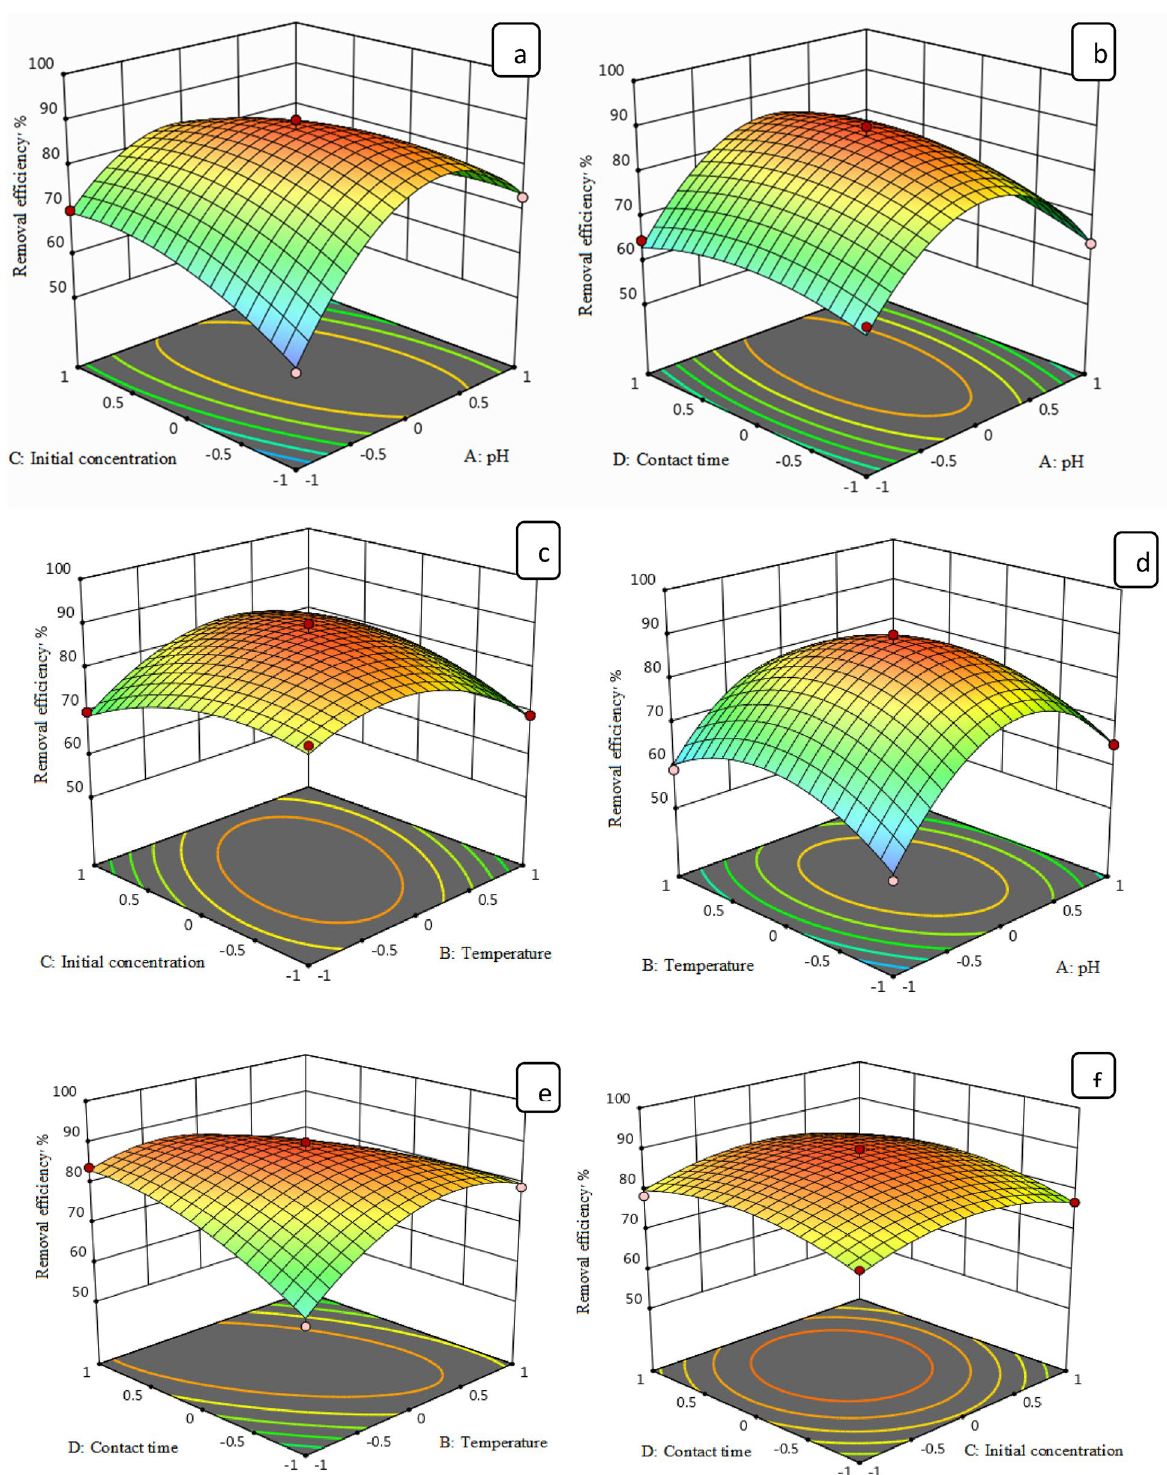
Fig. 21 a Cumulative impact of pH and contact time, b cumulative impact of pH and MG dye concentration, c cumulative impact of pH and temperature, d cumulative impact of contact time and MG dye concentration, e cumulative impact of contact time and temperature, f cumulative impact of temperature and MG dye